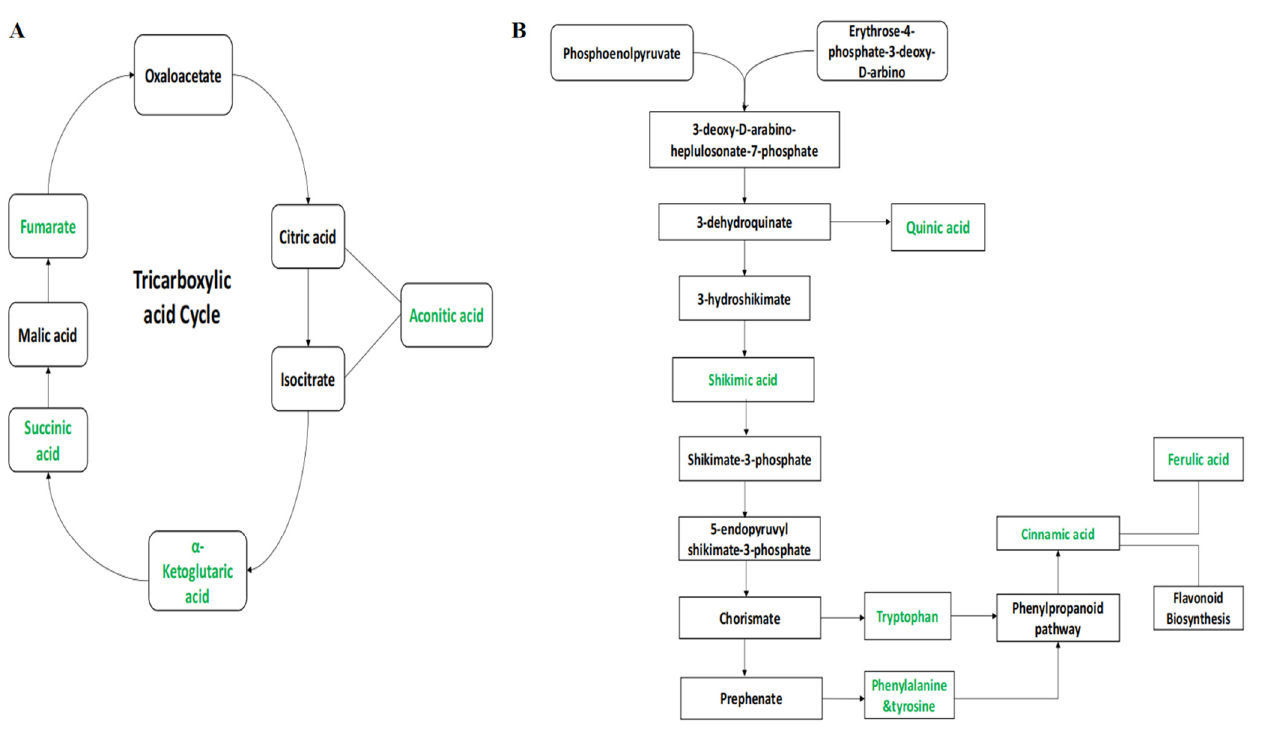
Figure 7. ( A ) Tricarboxylic acid cycle; ( B ) an overview of the secondary metabolites biosynthetic pathways.